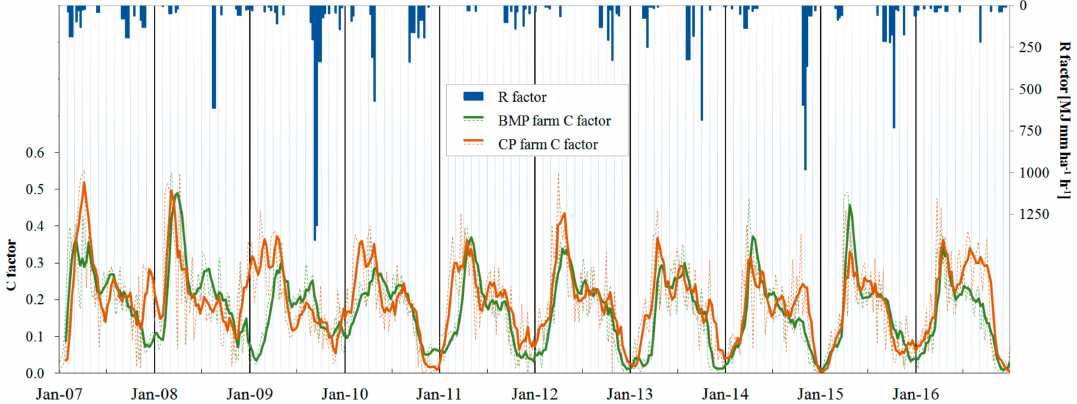
Figure 6. R and C factors calculated at event time-scale for the two vineyard plots during the investigated